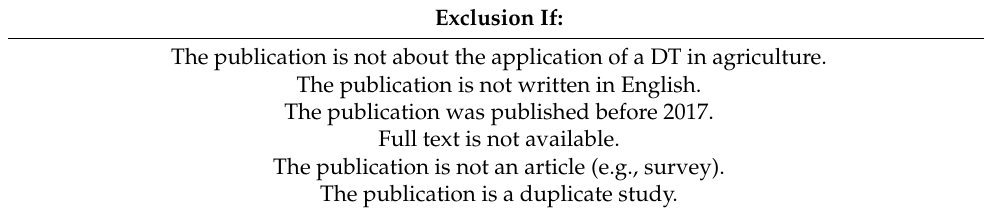
Table 2. Exclusion Criteria.